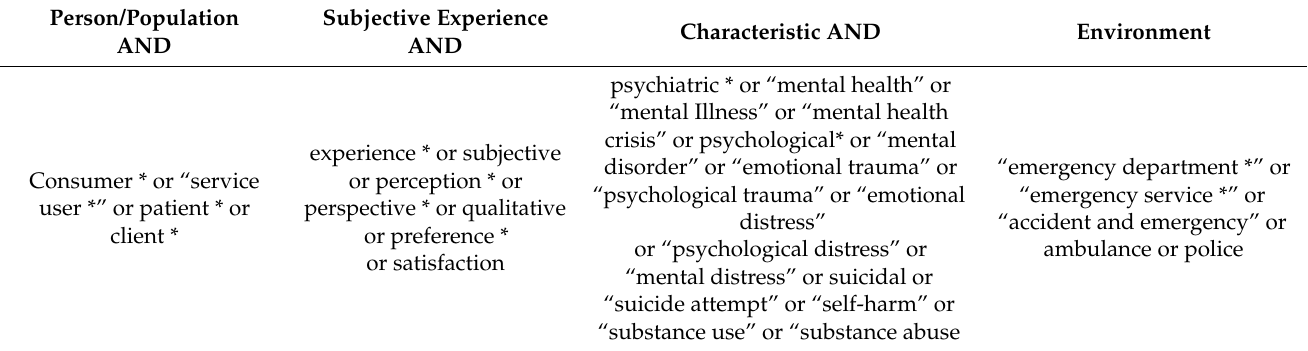
Table 1. Search terms used in the search